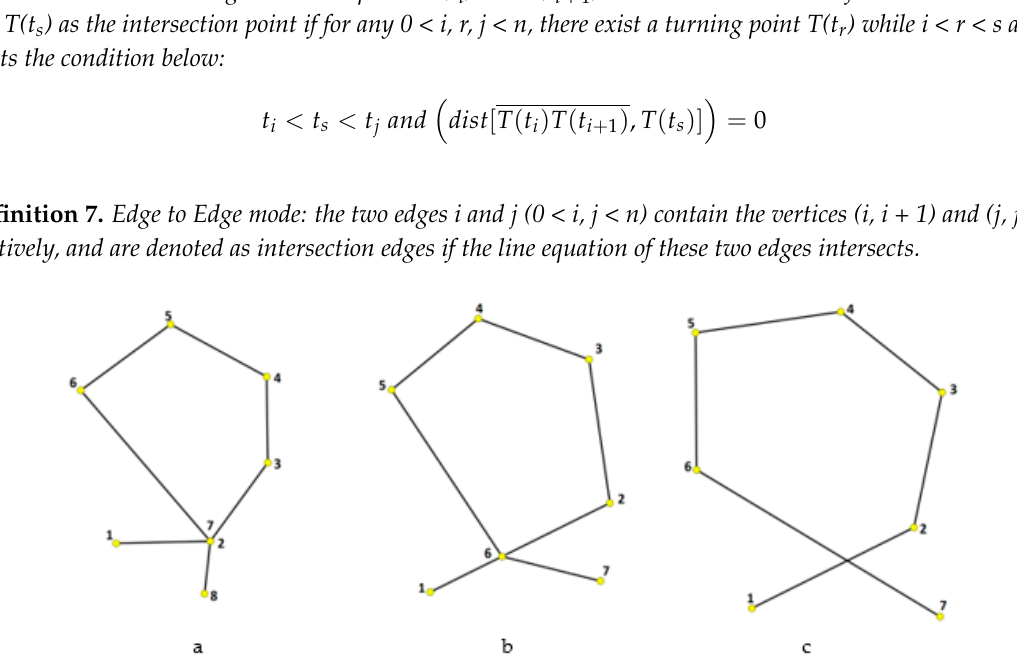
Figure 13. Deriving convex hulls to detect self-intersections in ( a ) simple intersected trajectory and ( b ) more complicated trajectory.